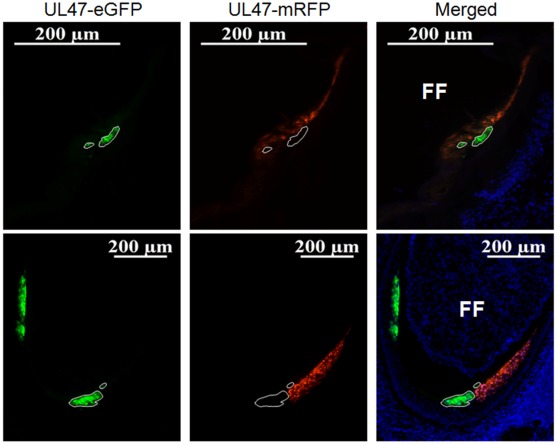
Superinfection inhibition in FFE cells by rMDV.Skin/feather tissues collected from chickens coinfected with vΔRLORF4-mRFP and vUL47-eGFP were examined using an Axio Imager M1 system at ×25. Regions where only vUL47-eGFP is replicating next to cells where only vΔRLORF4-mRFP were traced using Adobe Photoshop and transferred to the accompanying single color image to better show the distinct separation of colors. Feather follicles (FF) are indicated.